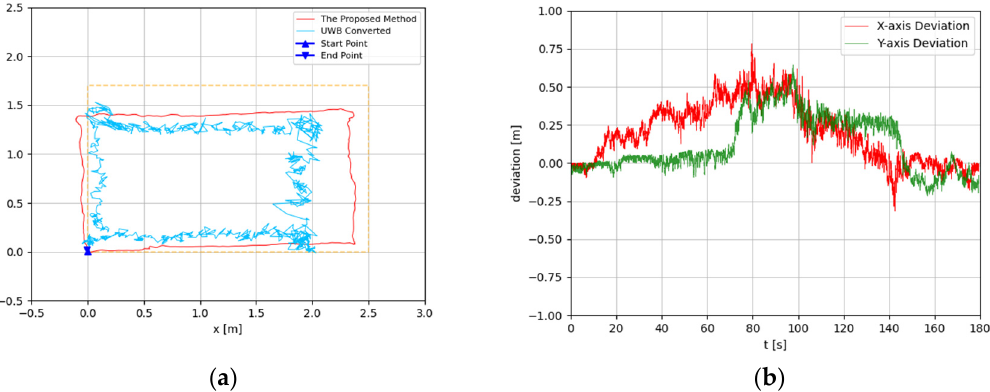
Figure 8. ( a ) Trajectory of rectangle-shaped the first test; ( b ) Positioning comparison of rectangle- shaped the first test.